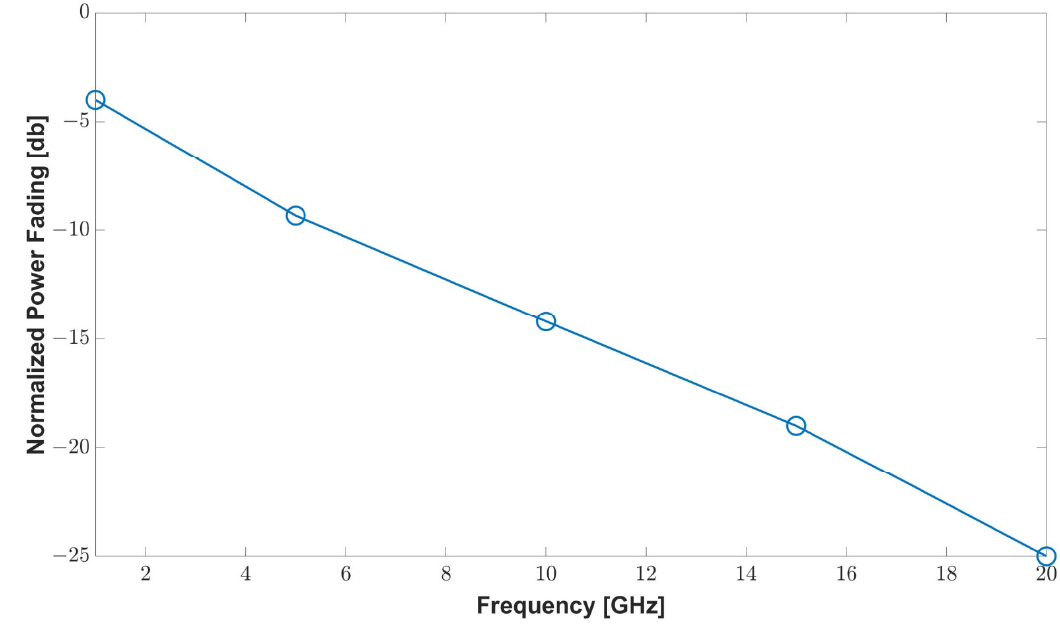
Figure 9. Power fading w.r.t frequency range covering the two intermediate frequencies.